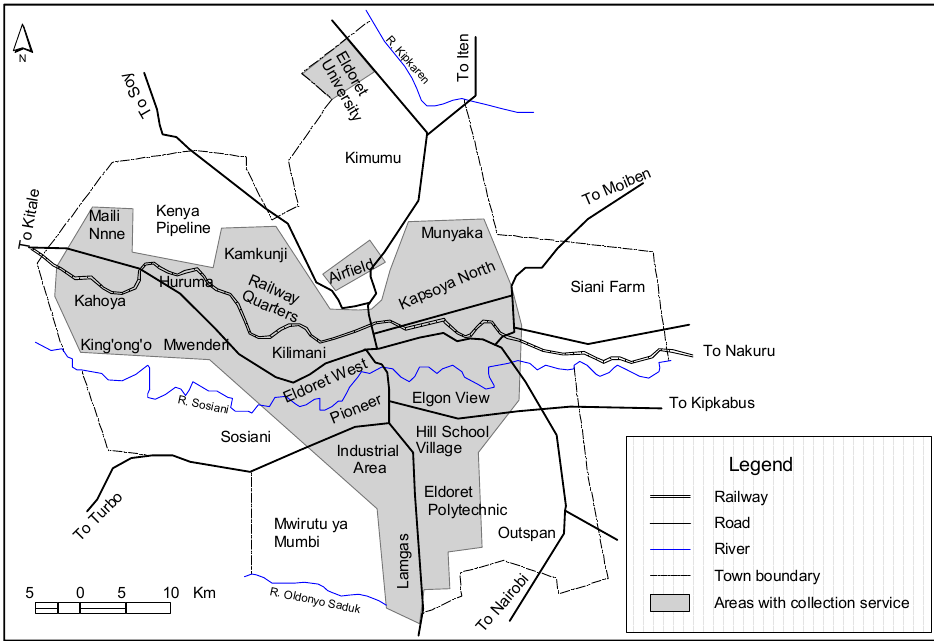
Fig. 2: Coverage by solid waste collection service in Eldoret Town (The Director of Environment and Enforcement, 2018)